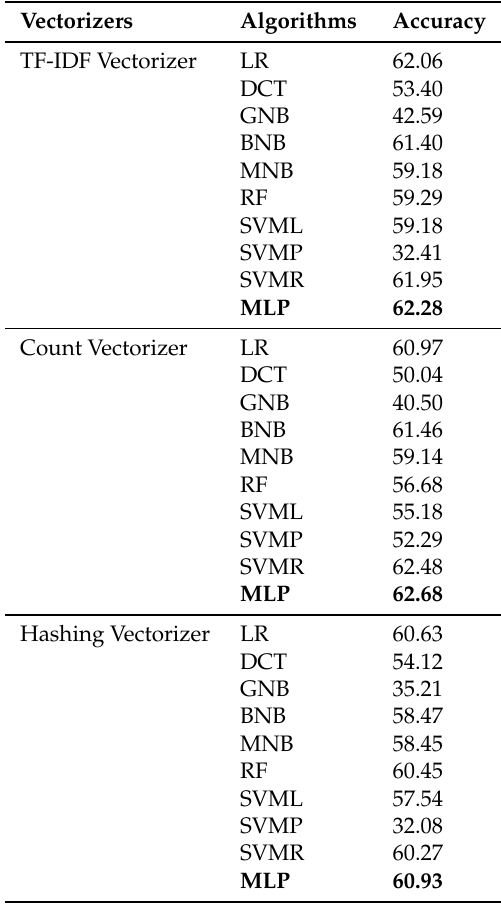
Table 7. Training Score Results for Marglish dataset.